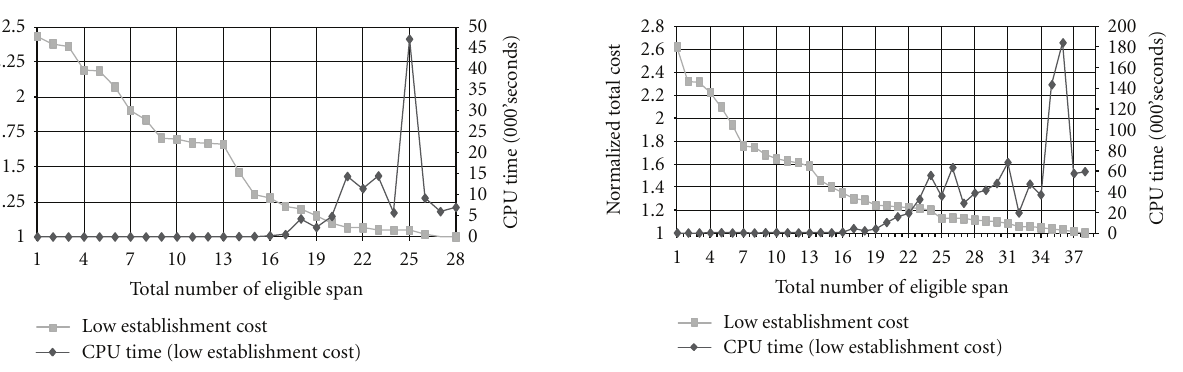
Figure 6: Total network costs and CPU time versus the number of eligible spans for the 30-node network.